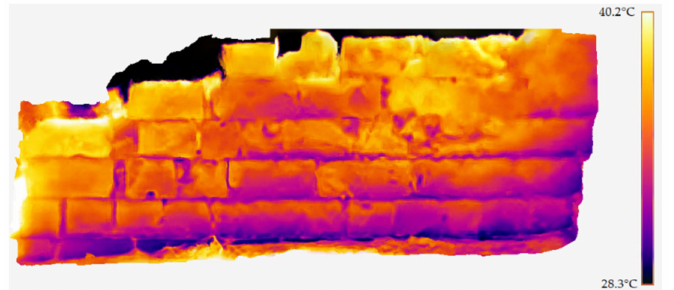
Figure 18. Thermal orthomosaic of an ancient wall at the archaeological site of